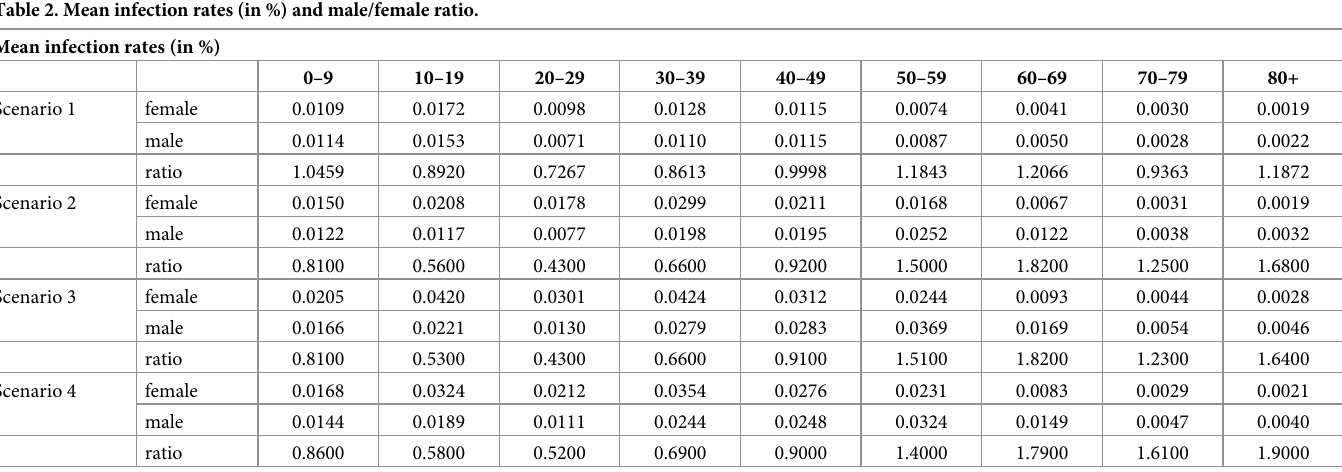
Table 2. Mean infection rates (in %) and male/female